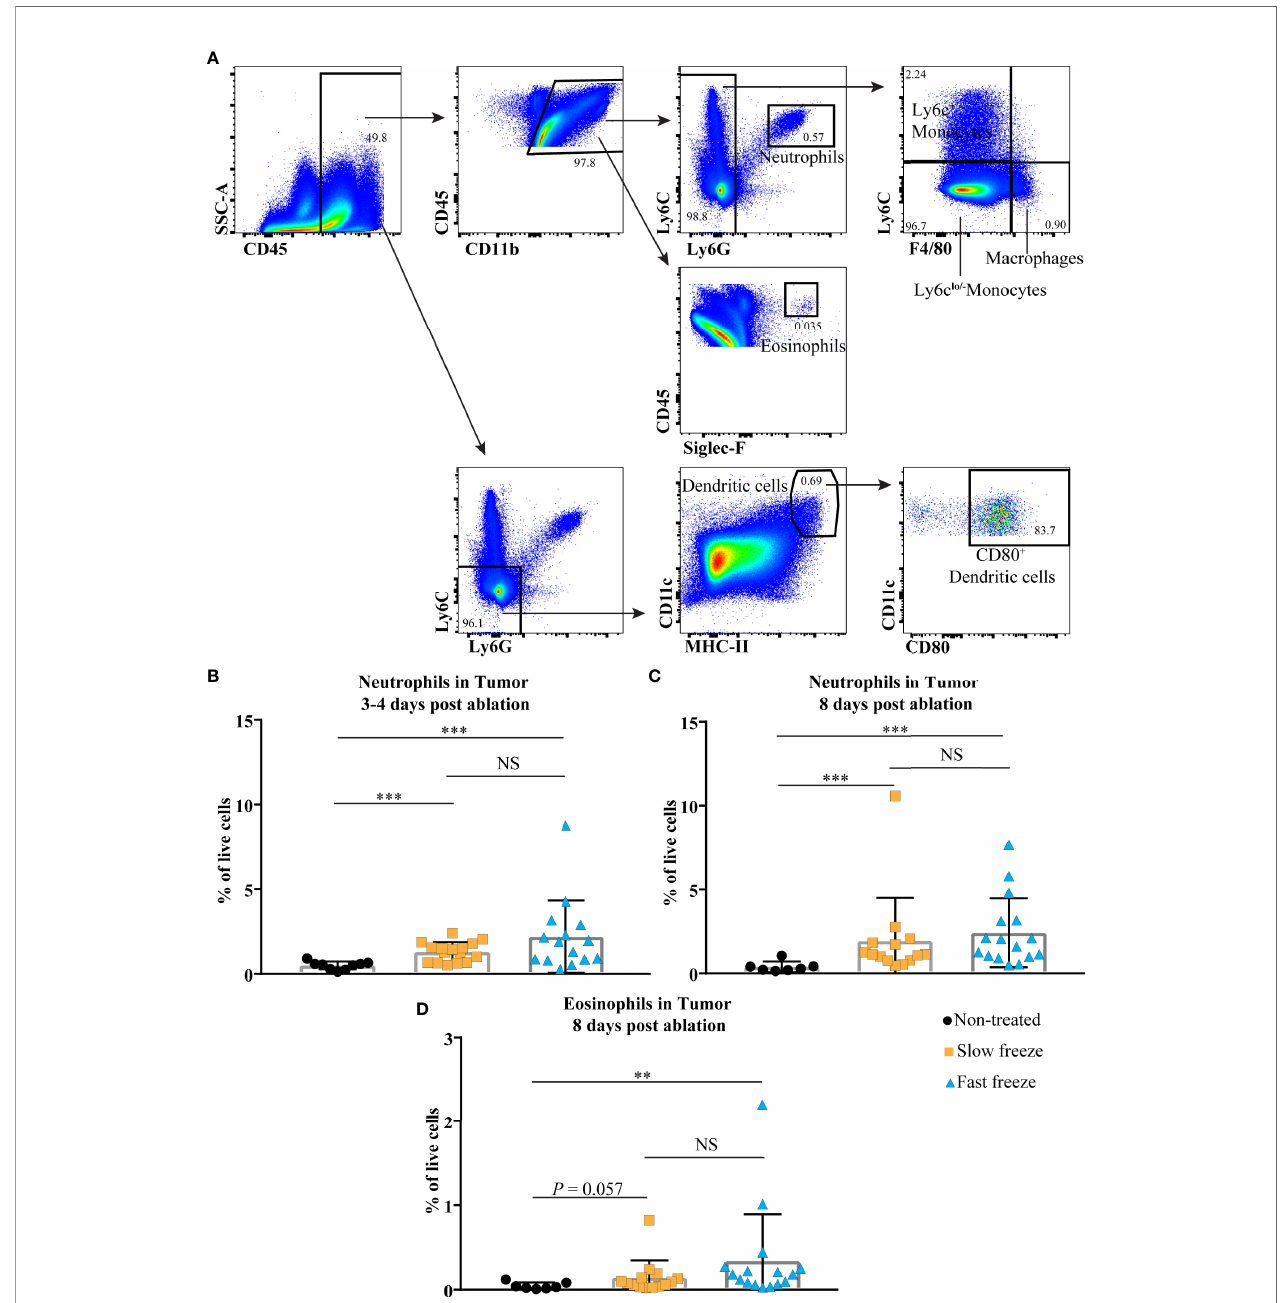
FIGURE 4 | Cryoablation-induced changes in the tumor in fi ltrating myeloid cells. (A) Flow cytometry gating strategies employed to characterize tumor in fi ltrating myeloid cells. (B, C) Percentages of neutrophils within live cells at days 3-4 and 8 post cryoablation. (D) Percentages of eosinophils within live cells at day 8 post cryoablation. Data plotted as mean and ± S.D. obtained from four independent experiments (n = 7-16). Each data point represents an individual mouse. Data was analyzed using non-parametric Mann-Whitney U test. ** P < 0.01, *** P < 0.001. NS, not signi fi